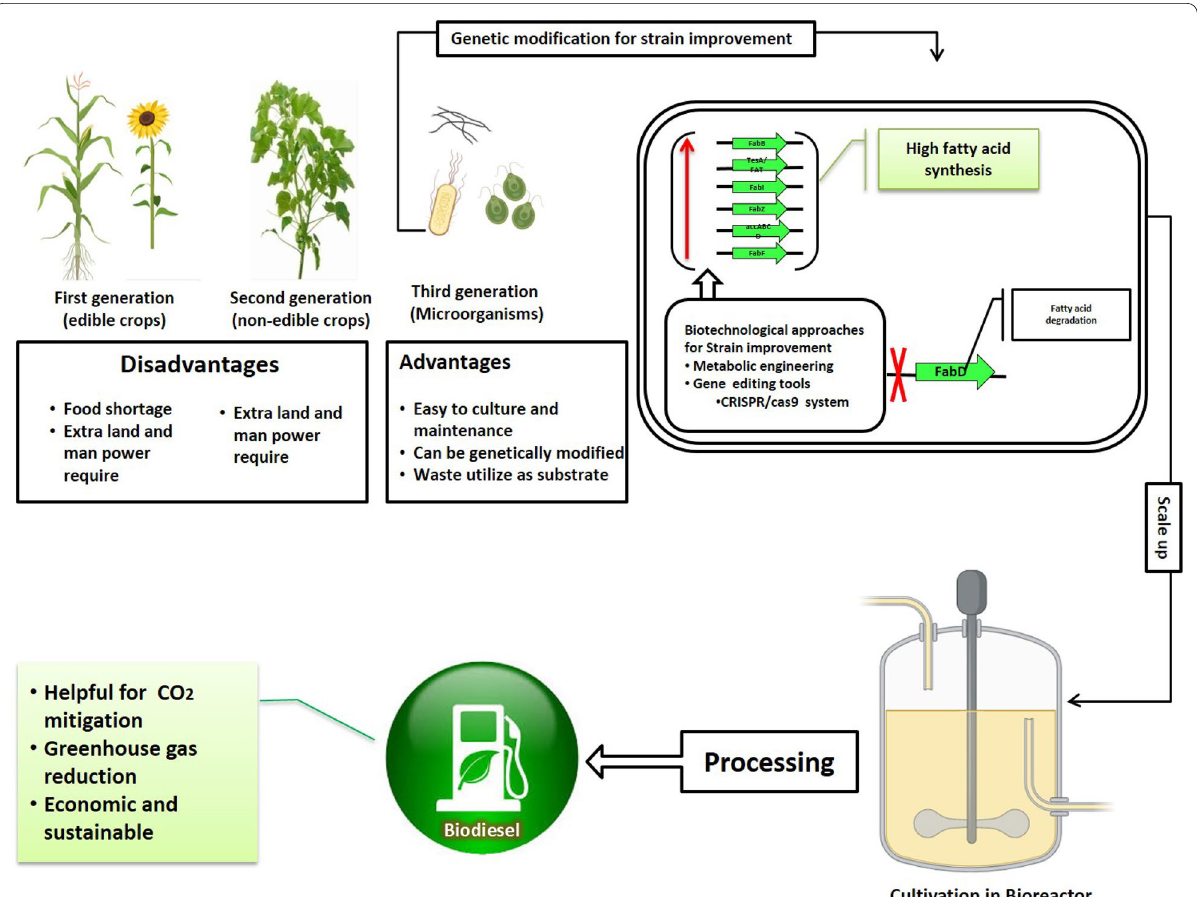
Fig. 5 Generations of biodiesel, and future possibilities of biodiesel production from oleaginous bacteria by genetic modifications